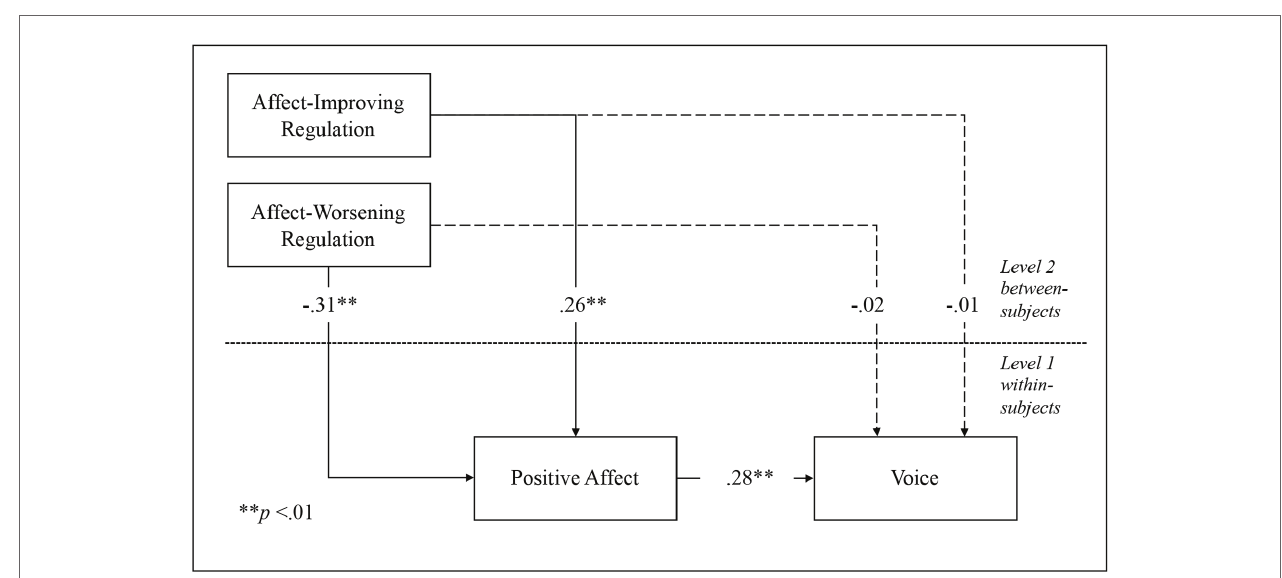
FIGURE 1 | MSEM for voice, positive affect, and emotion